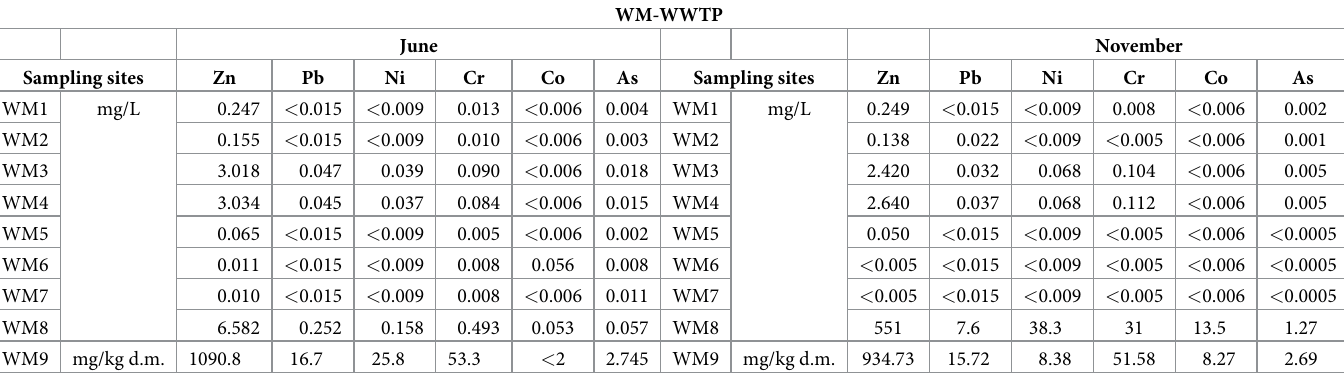
Table 2. Average concentration of analyzed heavy metals (mg/L and mg/kg d.m.) in samples from